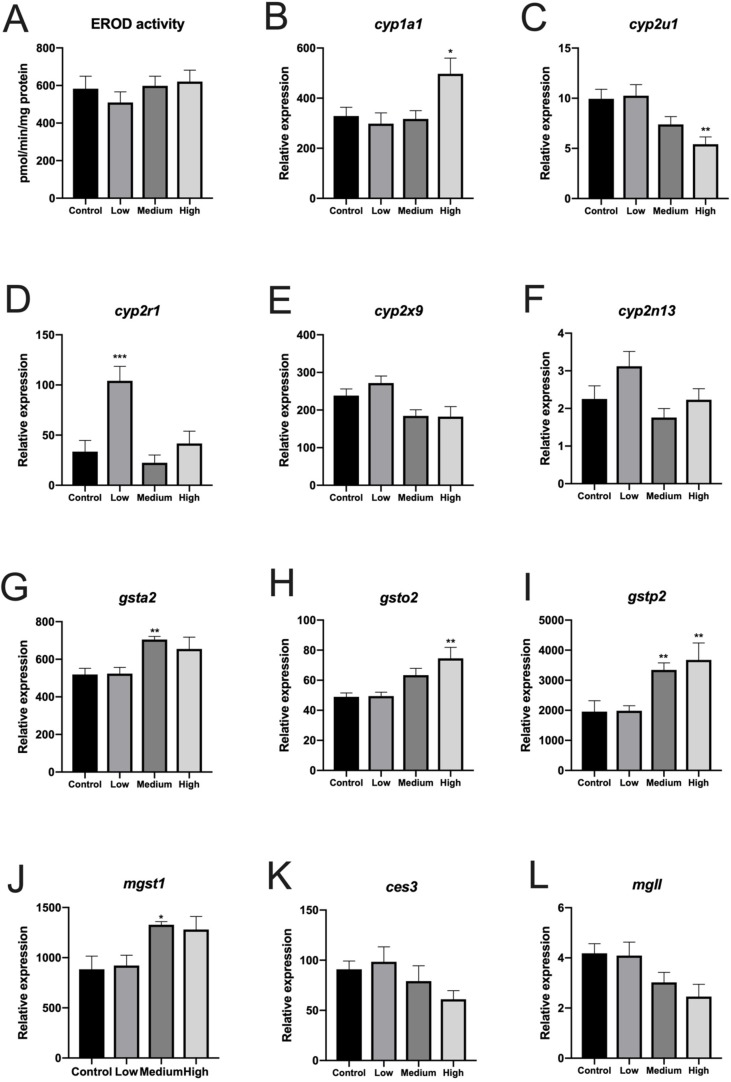
7-Ethoxyresorufin-O-deethylase activity and expression of selected genes (RNA-seq data) in liver of Atlantic cod exposed to three concentrations of chlorpyrifos-methyl for 30 days. (A) EROD activity, (B)cyp1a1, (C)cyp2u1, (D)cyp2r1, (E)cyp2x9, (F)cyp2n13, (G)gsta2 (resemble human gsta1 and zebrafish gstal), (H), gsto2, (I)gstp2, (J)mgst1, (K)ces3, and (L)mgll. n = 6. B–L show relative transcript values based on fragments per kilobase of sequence per million mapped reads. Mean ± SEM.